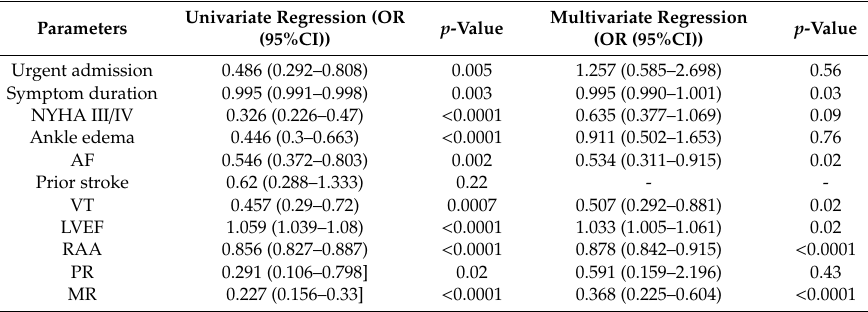
Table 2. Association between parameters and low PH risk.